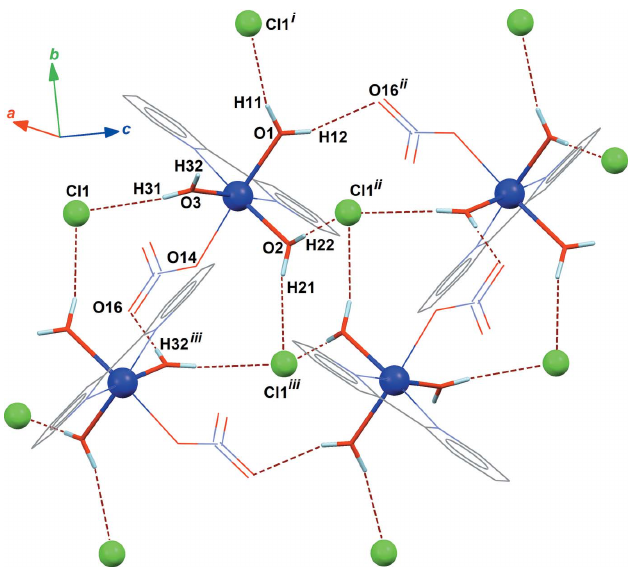
Figure 2 Part of the crystal structure of the title compound showing four cations and ten chloride forming hydrogen bonds (dashed lines). H atoms belonging to the bipy ligands have been omitted for clarity. The asymmetric unit contains the upper-left cation and Cl1. Symmetry codes: (cid:3) z ; (ii) x , 1 (cid:3) y , 1 (cid:3) z . (i) (cid:3) x , 1 + y , 1 + z ; (iii) (cid:3) x , (cid:3) 1 + y , 1 2 2 2 2 2 2